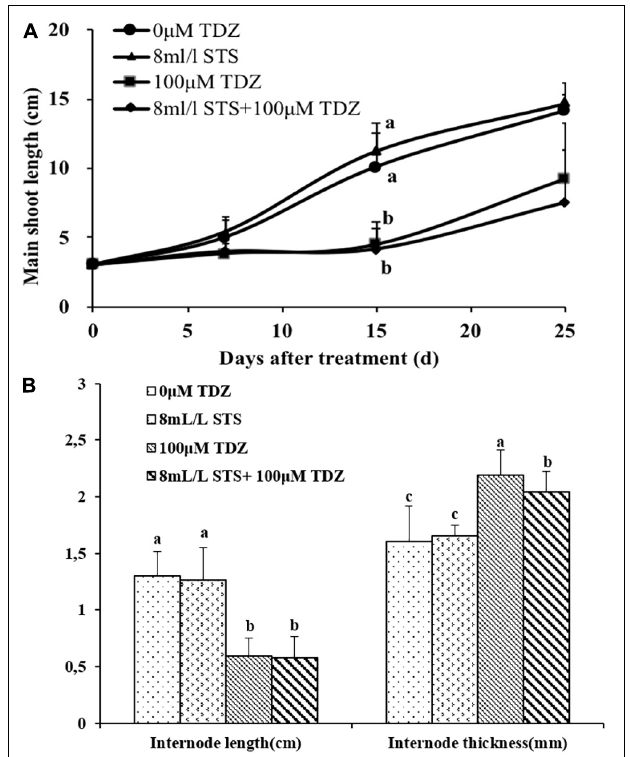
FIGURE 7 | Effects of the ethylene biosynthesis inhibitor AVG at 0.5 mM and 100 µ M TDZ applications alone and together on the main shoot length (A) and third internode length and thickness (B) of potted miniature rose plants. The main shoot length was measured on 5, 10, 15, and 21 days, while the data on the third internode length and thickness were taken after 3 weeks. Means ( ± SE, n = 16) within days (A) and length or thickness (B) with different letters are significantly different at P ≤ 0.05.